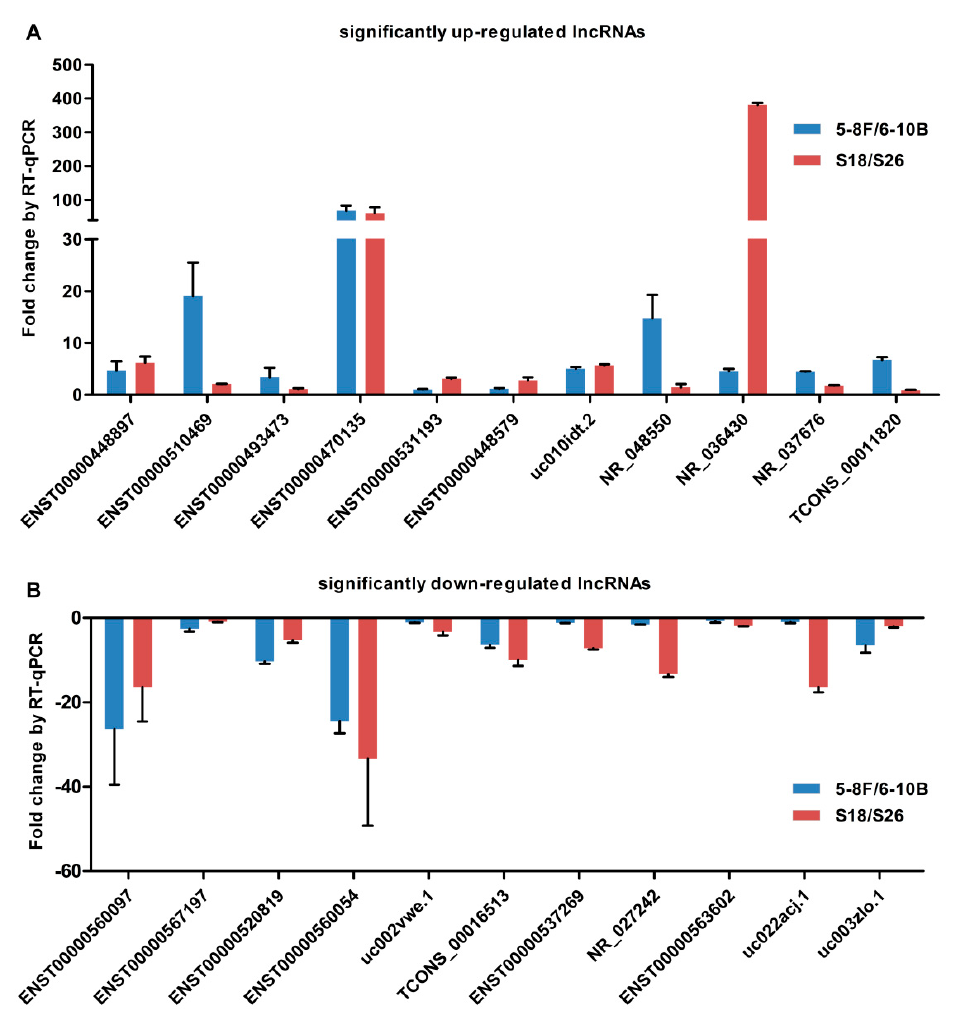
Figure 3. Validation of significantly dysregulated lncRNAs by qRT-PCR. The figure shows the expression patterns of 22 lncRNAs including 11 upregulated ( A ) and 11 downregulated ( B ) were consistent with the microarray data.